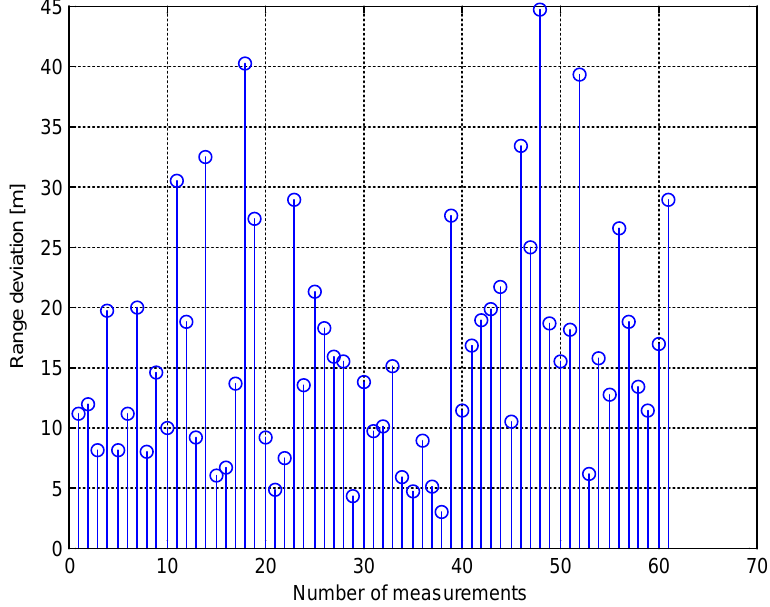
Figure 6. The range deviation of the target (simulation 2).